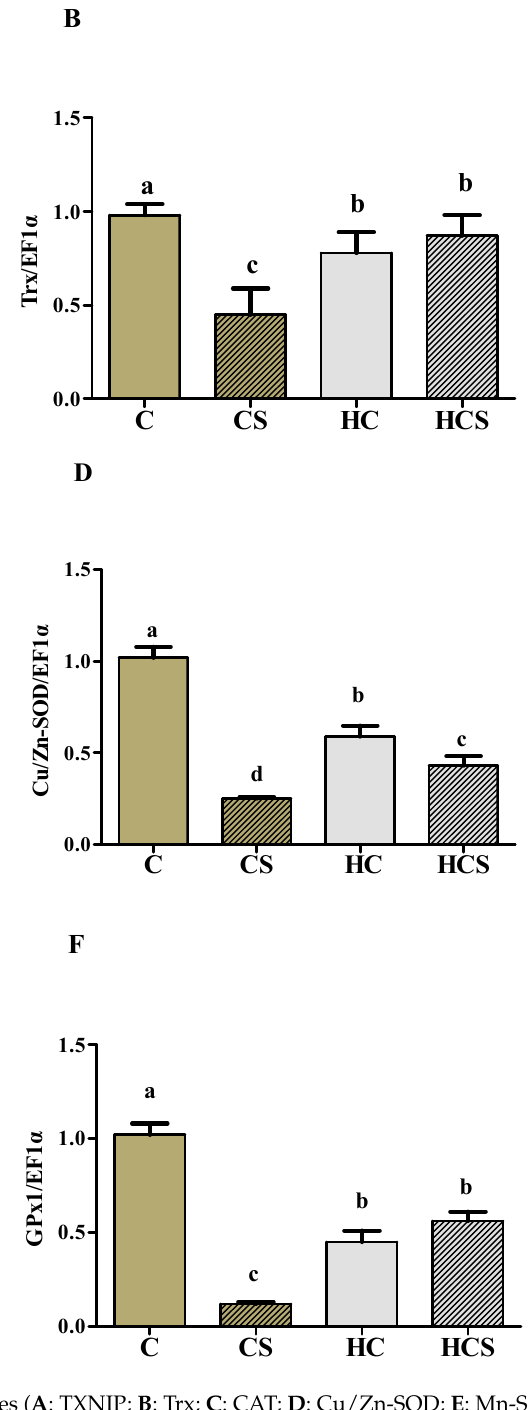
Figure 5. Hepatic transcriptional levels of antioxidant-related genes ( A : TXNIP; B : Trx; C : CAT; D : Cu/Zn-SOD; E : Mn-SOD and F : GPx1) of M. amblycephala subjected to different treatments. Each data point represents the means ± SEM of four replicates. Bars assigned different superscripts (a, b, c and d) are significantly different ( p < 0.05).